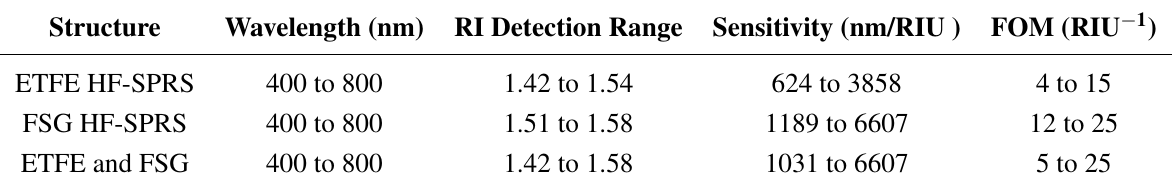
Figure 7. ( a ) Sensitivities of ETFE and FSG HF-SPRS: using the ETFE HF-SPRS and FSG HF-SPRS in the refractive index (RIs) range below and above 1.51, respectively; ( b ) FOMs versus n . s Table 1. Characteristics of the